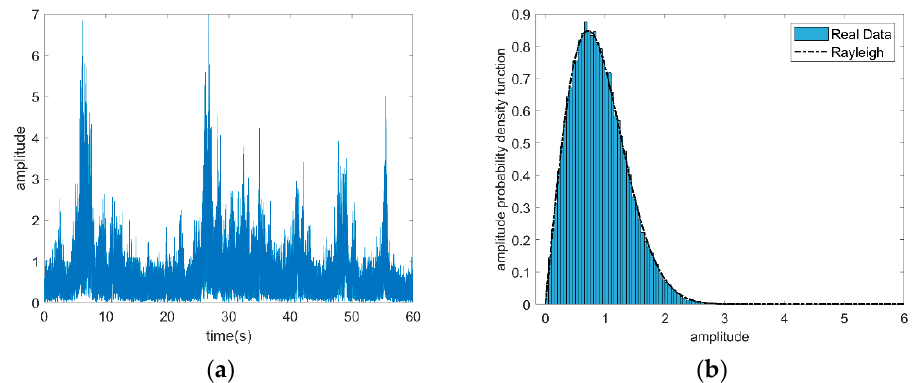
Figure 7. Amplitude information of the real data: ( a ) amplitude of the real data; ( b ) PDF of the real data amplitude after preprocessing.